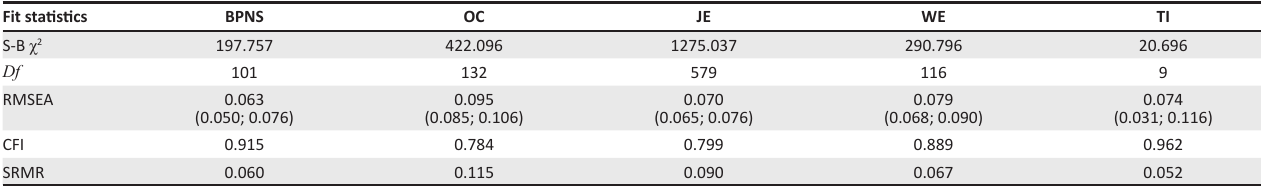
TABLE 3: Goodness-of-fit statistics. Fit